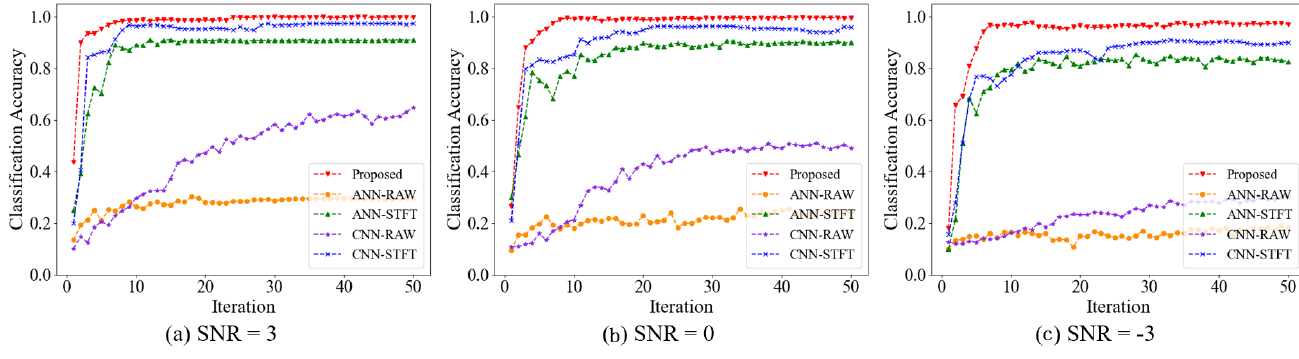
Figure 18. The classification accuracy of different methods under different SNRs (testing on DUT